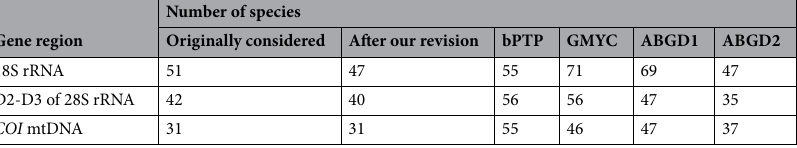
Table 3. Comparing the number of established species and molecular species-delimitation results according to different species-delimitation methods of Criconematidae with sequence representatives in GenBank.